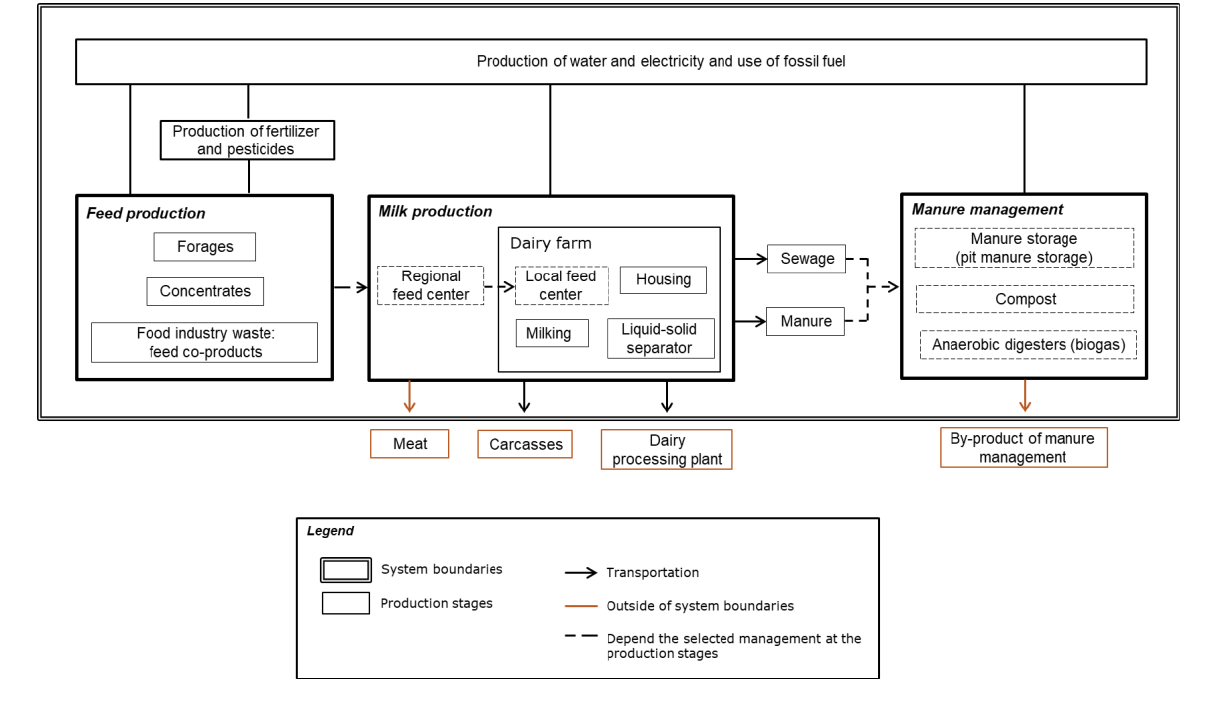
Figure 1. Research system boundaries.